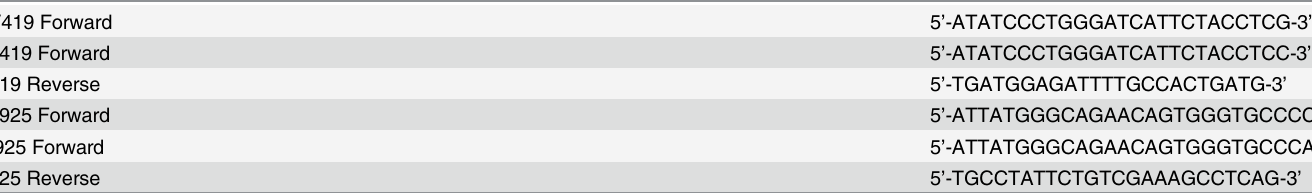
Table 1. Primers used to amplify kdr